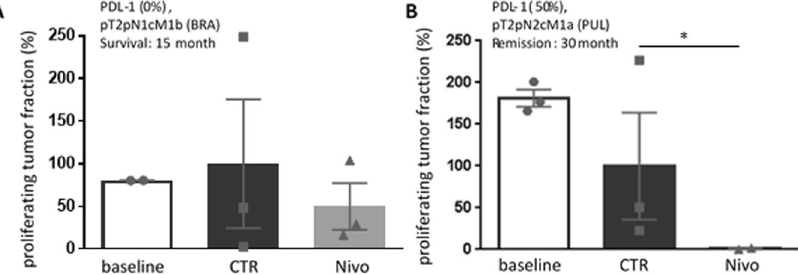
Fig. 6 NSCLaC tissue culture susceptibility to nivolumab correlates with patients ’ clinical response. Tumor specimens from two patients, A a clinical nonresponder and B a clinical responder, were treated ex vivo with nivolumab (Nivo). Cell proliferation was evaluated after 5 days. * p < 0.005 Mann – Whitney